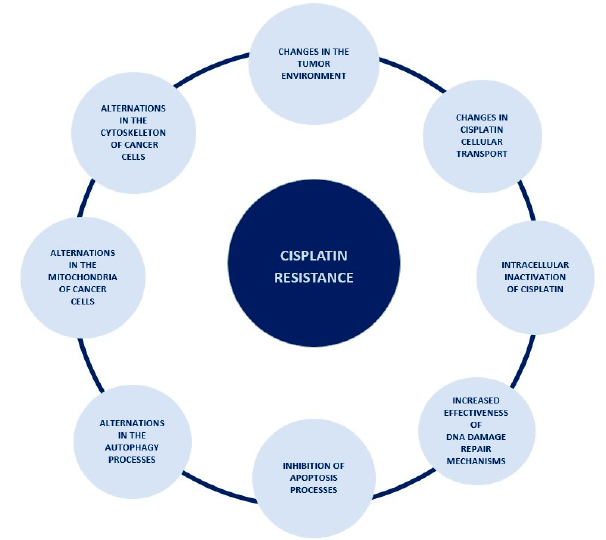
Figure 2. The spectrum of occurrences lying behind the mechanism of cisplatin resistance. 5. Strategies to Increase the E ff ectiveness of Cisplatin in the Treatment of Ovarian Cancer Due to the growing problem of the development of resistance to cisplatin by ovarian cancer cells, methods of increasing the e ffi ciency and e ff ectiveness of the cytotoxic e ff ect of cisplatin, as well as methods of inhibiting the mechanisms of resistance developed by cancer cells and restoring the sensitivity of these cells, are intensively sought. A particu- larly interesting strategy seems to be combination therapy—a therapy consisting of com- bining two or more agents with cytotoxic activity, for example, several drugs, or a drug with ionizing radiation or high temperature [5,19,20,79,80]. The examples of potential combination therapies with cisplatin were further discussed in the following subsections and summarized in Table 1. Although platinum compounds are still the main therapy for ovarian cancers, it is absolutely important to note that histopathological heterogeneity guides the therapeutic approach in a very important way. For example, in the case of mucinous ovarian carci- noma or ovarian clear cell carcinoma, which usually demonstrates a poor response to cis- platin treatment, the molecular therapy targeting VEGF (e.g., Bevacizumab), EGFR (e.g., Ge fi tinib), SCR pathway (e.g., Dasatinib) or Her2 receptor (e.g., Trastuzumab) seems to be more suitable [81–84].